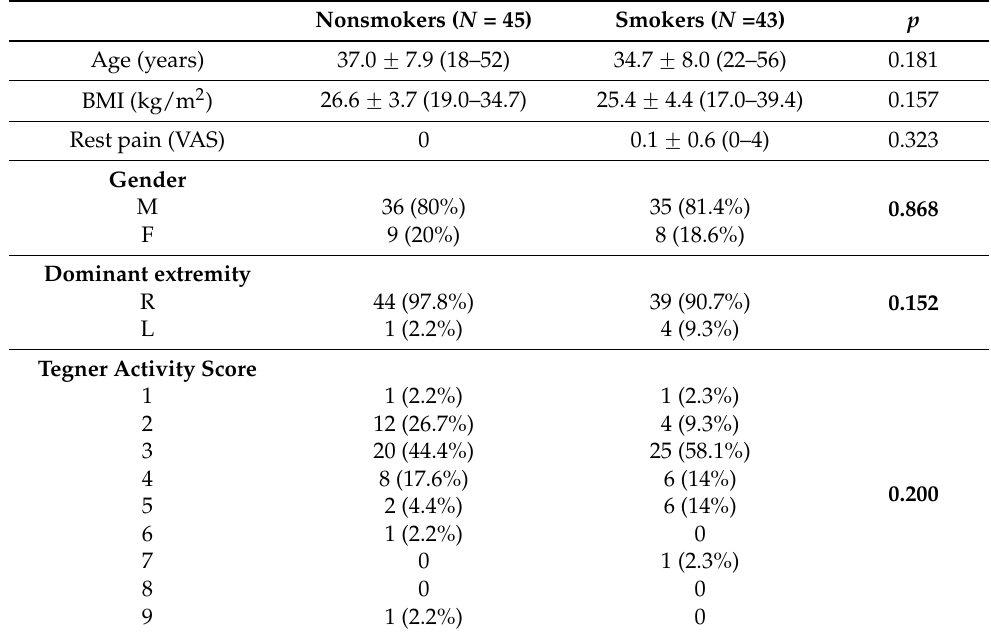
Table 1. Demographic features of the subjects.